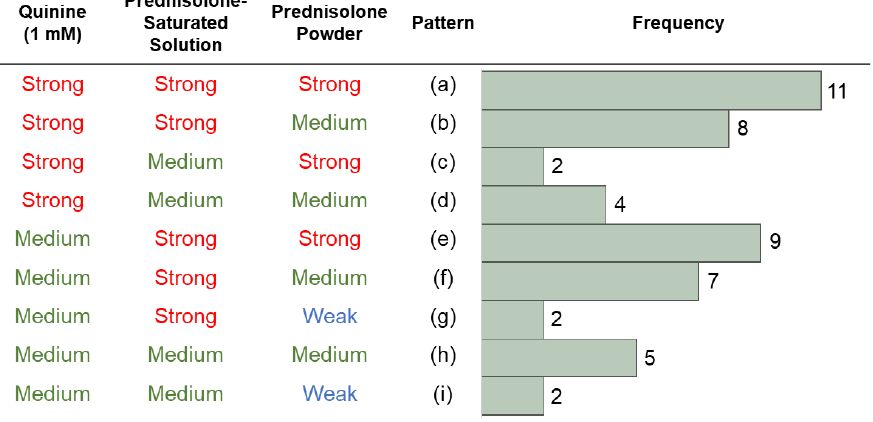
Figure 1. Histograms of the gLMS bitterness ratings by subjects ( n = 50) for each stimulus.